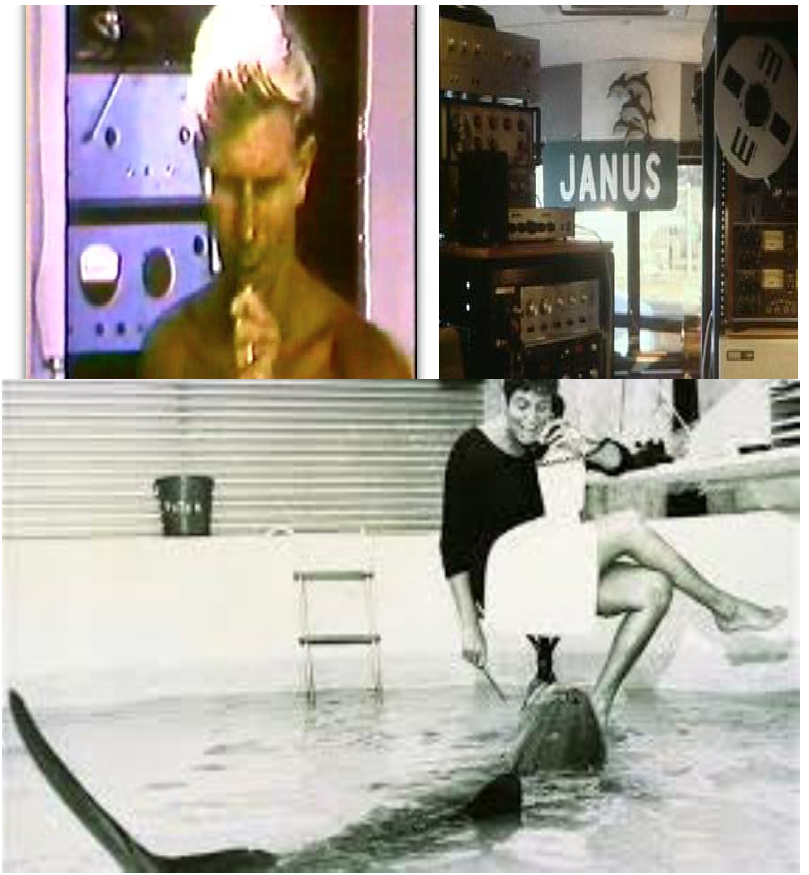
Figure 1. Early interface systems for dolphin communication. Upper left panel: Wayne Batteau and the Man/Dolphin Communicator. Upper right panel: John Lilly’s Project JANUS. Lower panel: Margaret Howe in the Virgins Island Facility with Peter, a bottlenose